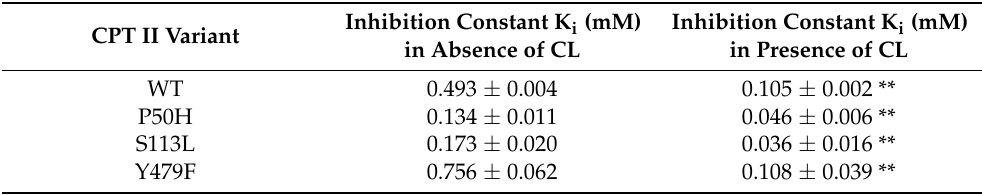
Table 3. Effect of 0.25 mM CL on the inhibition constant K i for the inhibitor R-amino carnitine at 25 °C ( n ≥ 3). CPT II Variant Inhibition Constant K i (mM) in Absence of CL